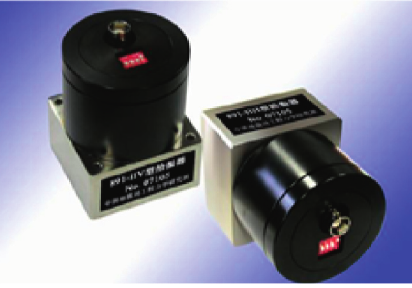
Figure 3: 891-2 vibration pickup.